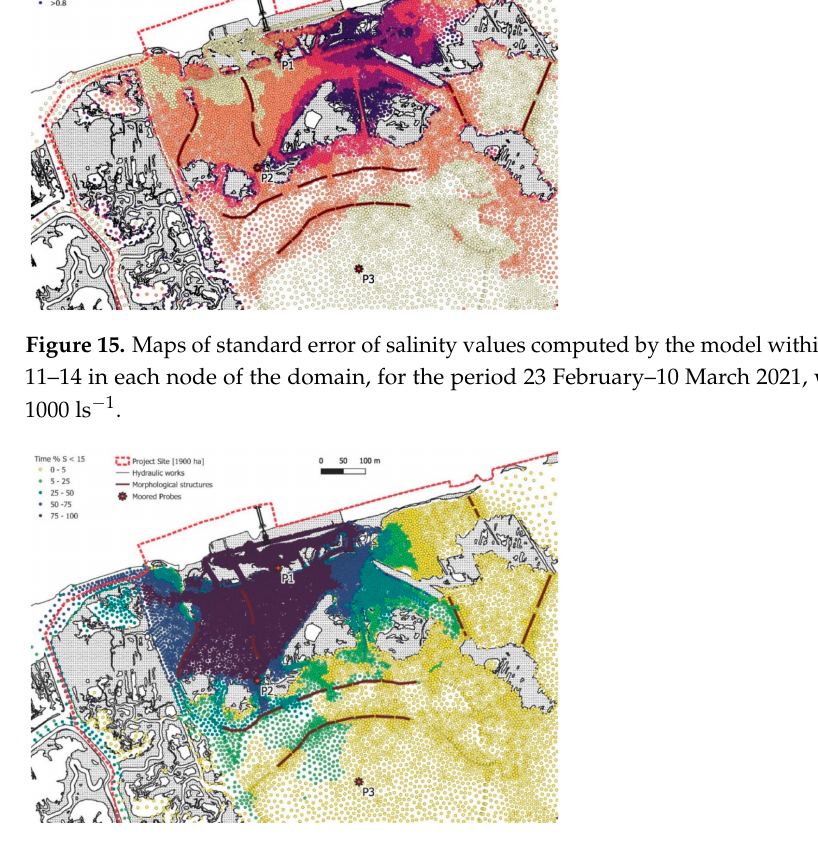
Figure 16. Maps of percentage of time with condition of salinity, evaluated as the mean value computed by the model within the vertical layers 11–14 in each node of the domain, <15 (condition for reedbed